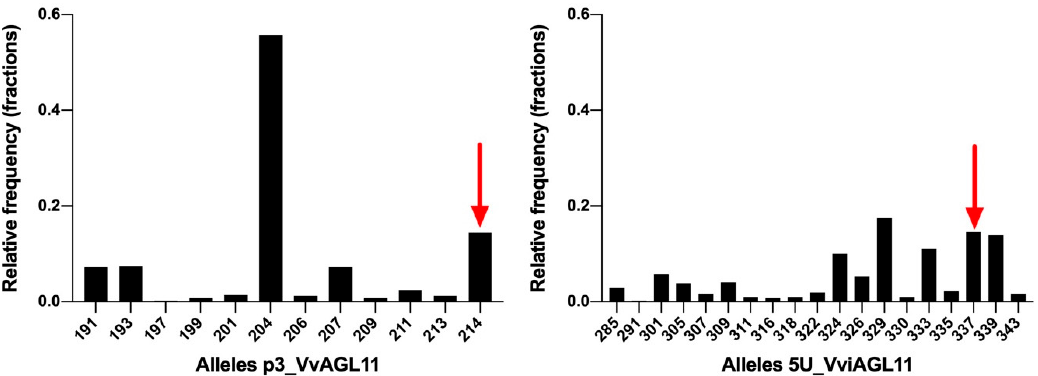
Figure 6. SSRs p3_VvAGL11 and 5U_VviAGL11 allele distribution in a collection of 209 unique Vitis vinifera individuals. Alleles include the M13 tail (+18 bp). Bars indicated by a red arrow correspond to the unique seedless allele.